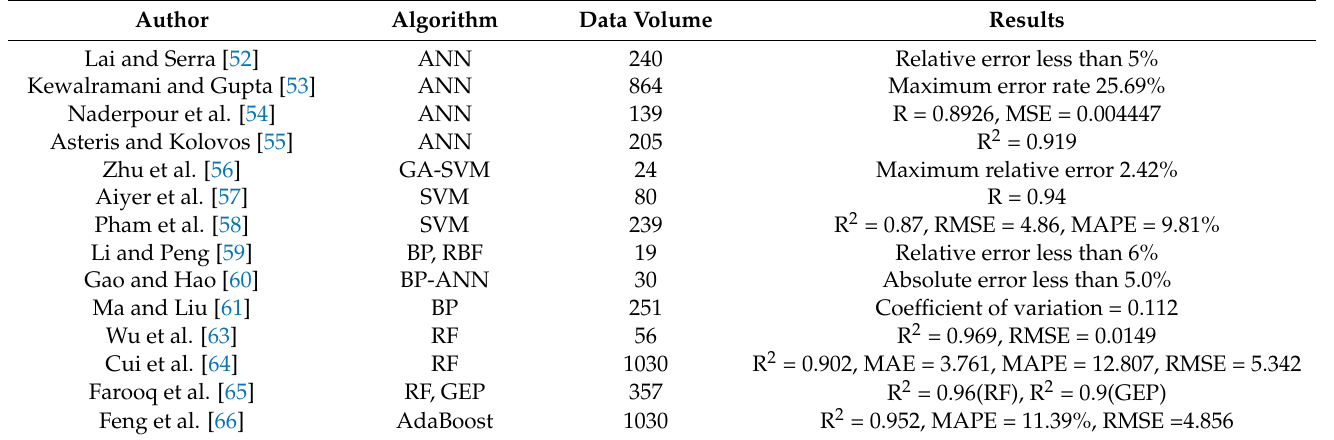
Table 4. Concrete-strength prediction methods using machine-learning